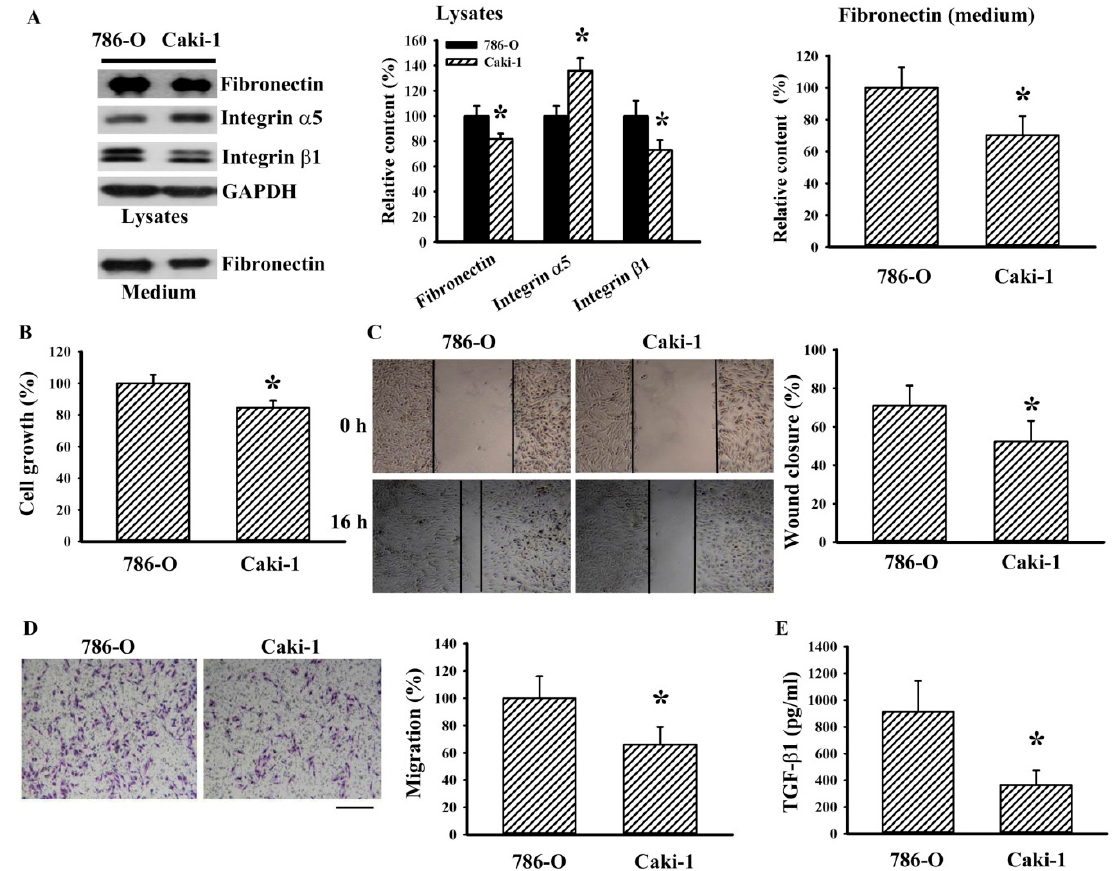
Figure 5. Cell growth and migration potential of RCC cells were associated with fibronectin. ( A ) 786-O and Caki-1 cells were seeded onto six-well plates and cultured for 24 h. Proteins were extracted from subconfluent (80%) cells (Lysates) and supernatants (Medium, 20 µ L) and subjected to Western blot analysis with indicated antibodies. Representative blots are shown. ( B ) 786-O and Caki-1 cells were seeded onto 96-well plates. Twenty-four hours later, cell growth was measured by MTS reduction assay. ( C ) 786-O and Caki-1 cells were seeded onto six-well plates for 24 h. When reaching confluence, cell movement was evaluated by a wound-healing assay for 16 h in the presence of 0.5% FBS. Representative photomicrographs are shown. Bar graphs show relative wound closure among groups. ( D ). 786-O and Caki-1 cells were seeded onto Transwell inserts and subjected to Transwell migration assay for 24 h. The lower chambers were filled with DMEM containing 10% FBS. Representative photomicrographs are shown. Scale bar = 100 µ m. ( E ) 786-O and Caki-1 cells were seeded onto 24-well plates. Twenty-four hours later, the supernatants were collected and subjected to ELISA for the measurement of TGF- β 1. Bar graphs show quantitative results among groups and the value in 786-O group was defined as 100% ( A , B , D ). * p < 0.05 vs. 786-O group, n = 3.